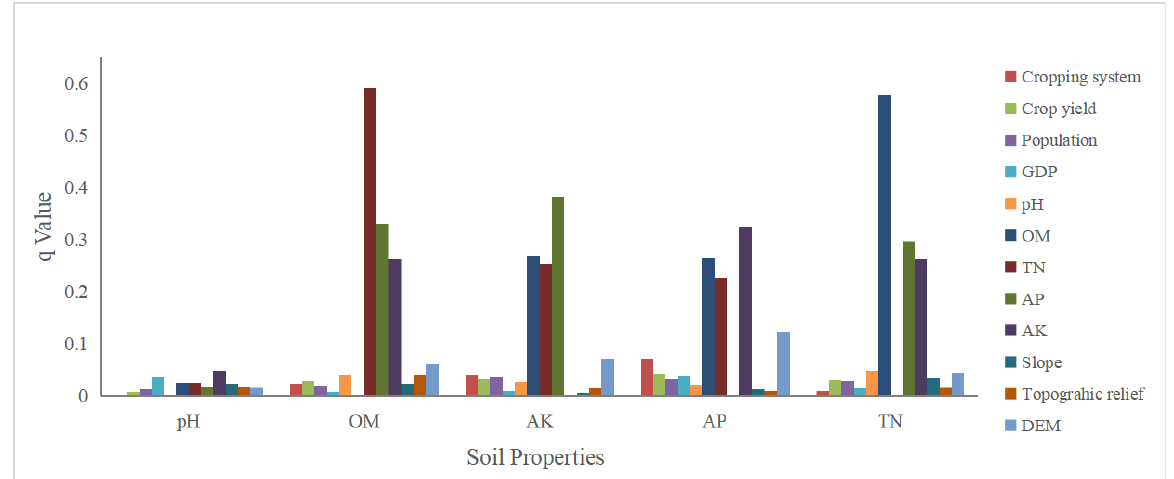
Figure 9. The q Value of the Influence Indicators on Soil Chemical Property. Note: